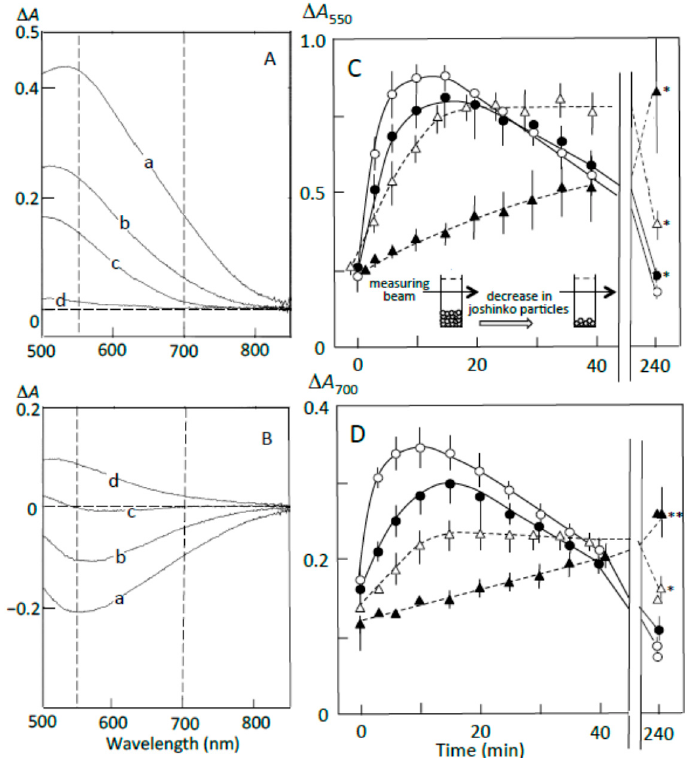
Figure 4. Pancreatin-induced starch digestion of retrograding joshinko. ( A , B ) ∆ A spectra of 3 min minus 0 min and 40 min minus 20 min of incubation, respectively. ( a ) 0 μ L, ( b ) 3 μ L, ( c ) 6 μ L, ( d ) 10 μ L of the adzuki extract. ( C , D ) Time courses of starch release and the digestion of released starch measured at 550 and 700 nm, respectively. ( ○ ) 0 μ L, ( ● ) 3 μ L , ( ∆ ) 6 μ L, ( ▲ ) 10 μ L of the adzuki extract. Each data point is the average with SD ( n = 3). * p < 0.05; ** p < 0.01. (cid:35)